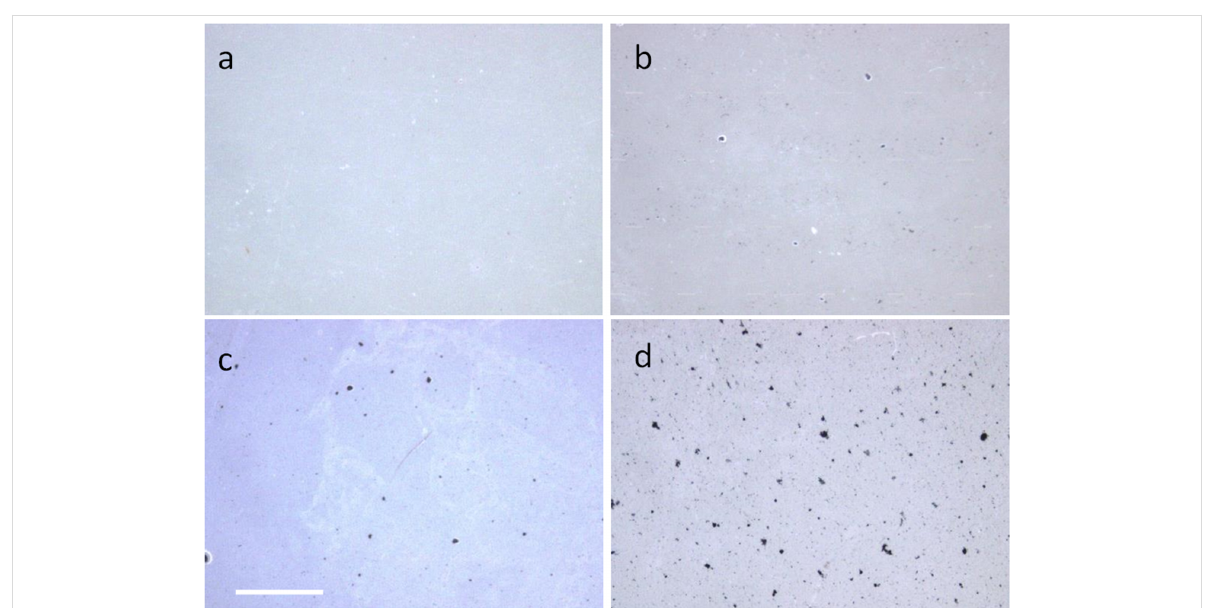
Figure 1: Optical stereomicroscope images (30× magnification) of PC composite films at different MWCNT loadings: a) 0, b) 1, c) 2 and d) 3 wt %. Scale bar: 100 µm, same for all images.